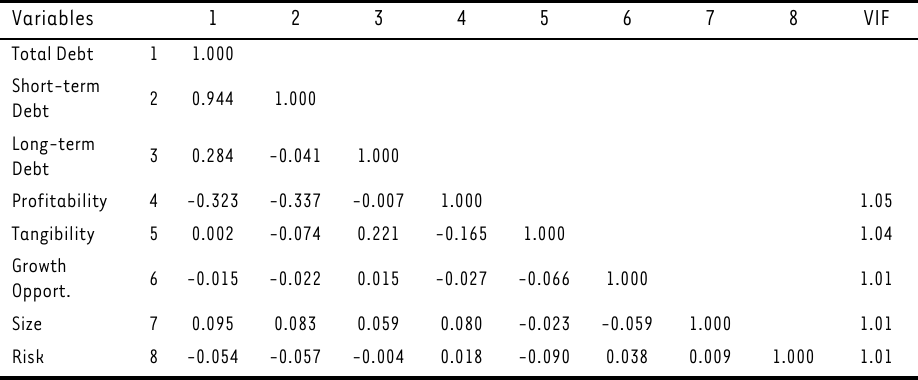
Pearson Correlation Coefficients between the dependent and the